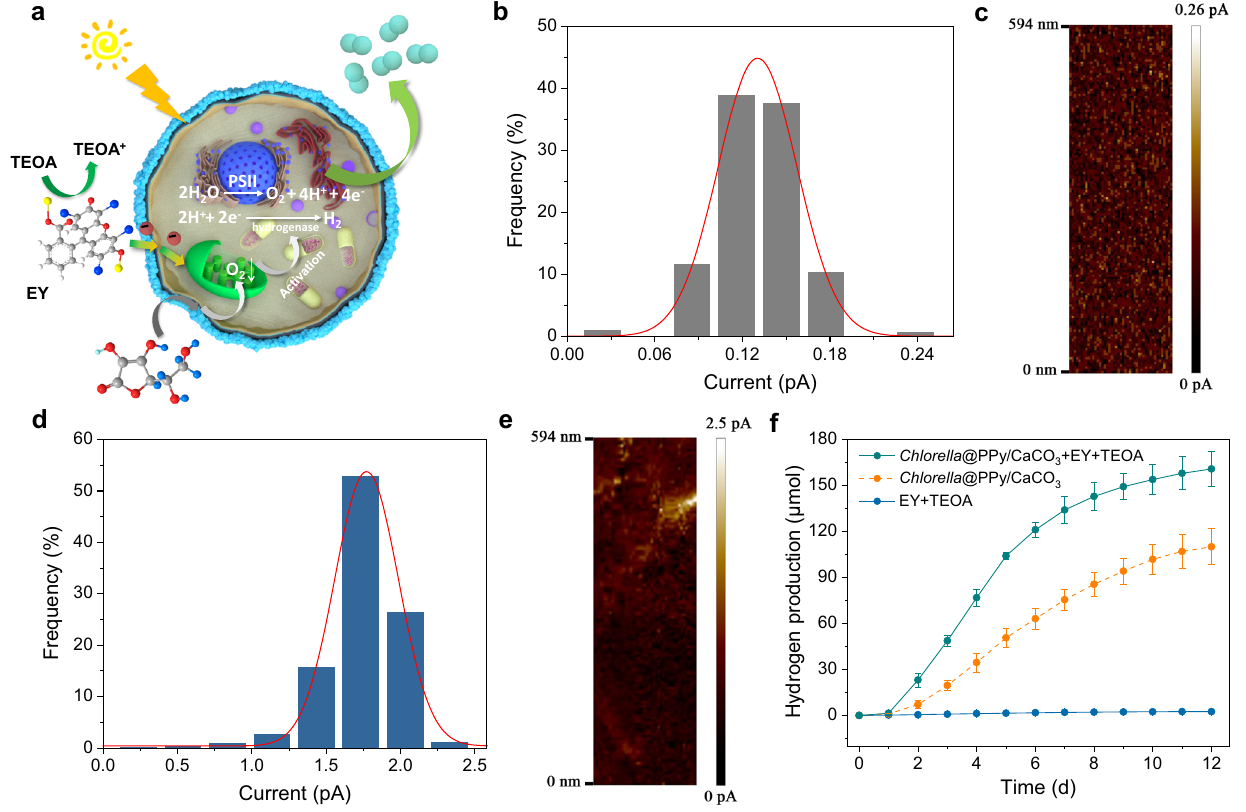
Fig. 3 | Enhanced extracellular photoelectron transport and hydrogen pro- ductioninsurface-conductivealgalcells.a SchematicillustrationofthePPyshell- mediated captureand translocationofarti fi cially generatedextracellularelectrons for enhanced hydrogen production (paired cyan circles) in surface-coated algal cells under air; molecular graphics for EY, TEOA and ascorbate are shown. b , c Histogram ( b ) of measured surface current for native Chlorella cells with the correspondingvalue-distributionimage( c ). d , e Histogram( d )ofmeasuredsurface current for PPy-coated Chlorella cells with the corresponding value-distribution image ( e ). The single peak fi tting is performed using a Gaussian curve in the